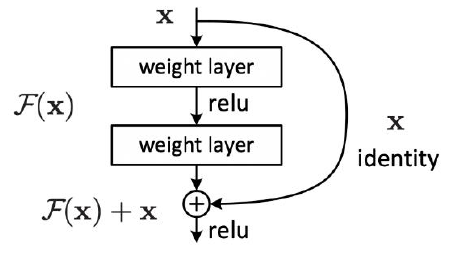
Figure 2 . A residual block (He et al., 2015)